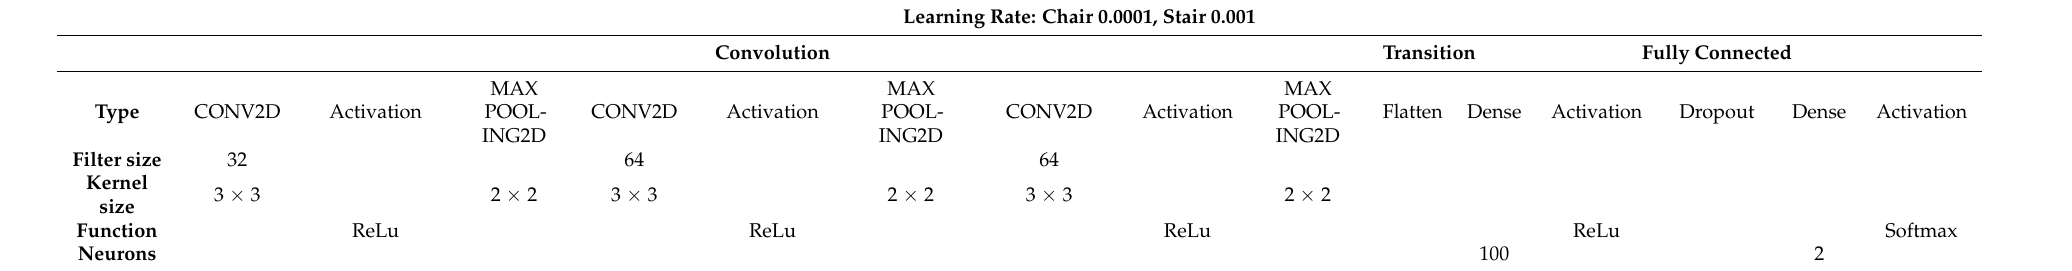
Table A2. Classification Level 2—Stair Up/Down, Chair Sit/Stand.